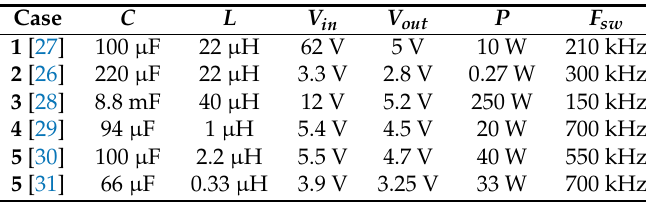
Table 5. Buck parameters used in the Results